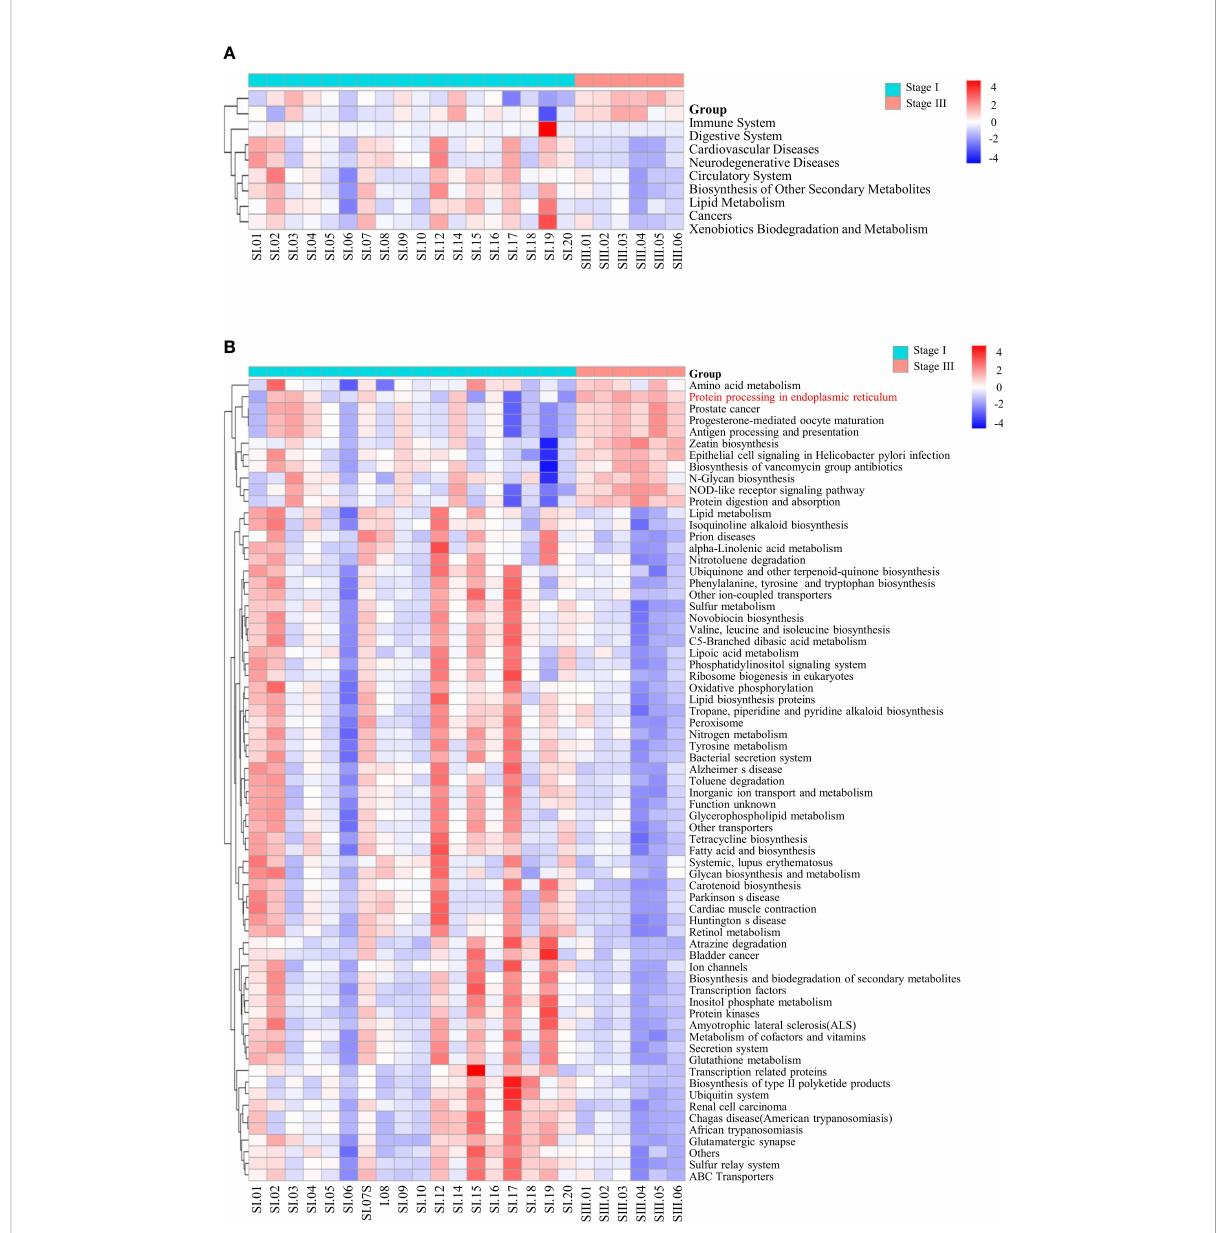
FIGURE 5 Pathway enrichment analysis. At the L2 (A) and L3 (B) level, using the KEGG database, the differences in all samples of women with stage-I or stage-III periodontitis were clustered into